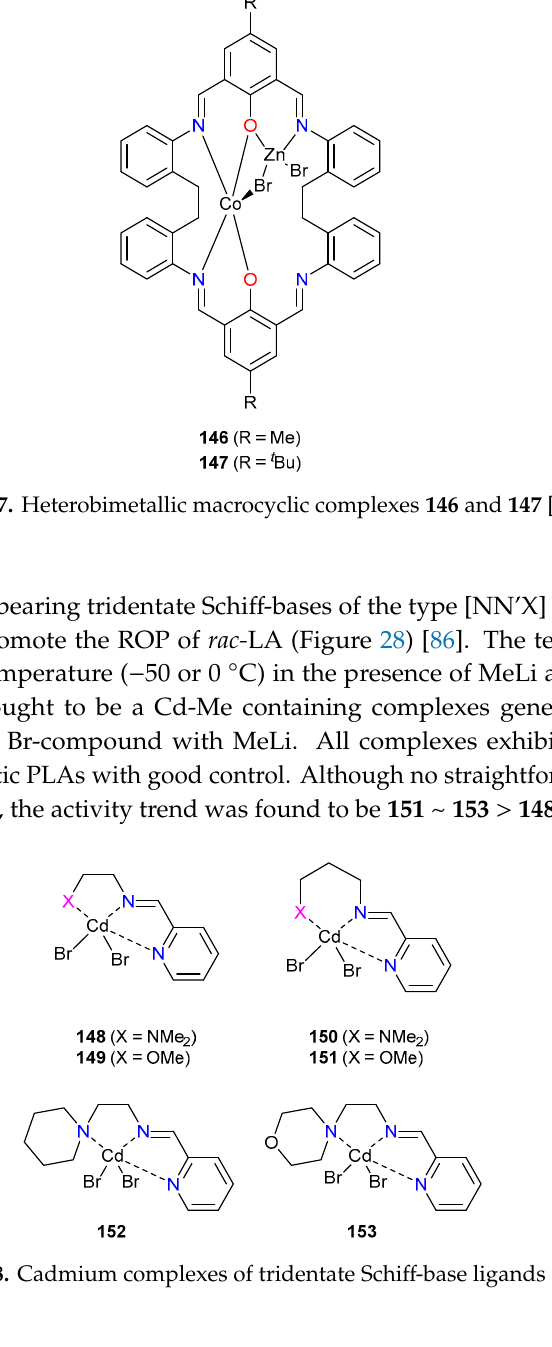
Figure 28. Cadmium complexes of tridentate Schiff-base ligands [86].